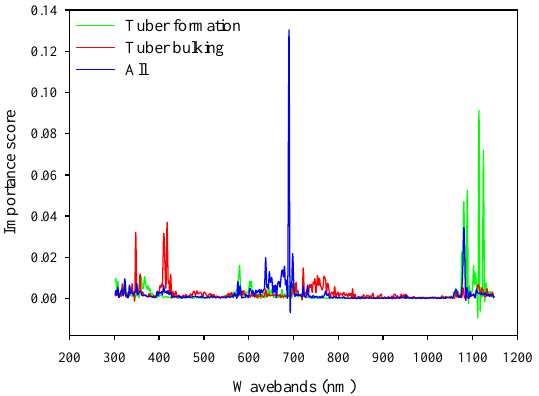
Figure 12. Comparison of the importance score for RF model based on full spectrum at different growth stages.